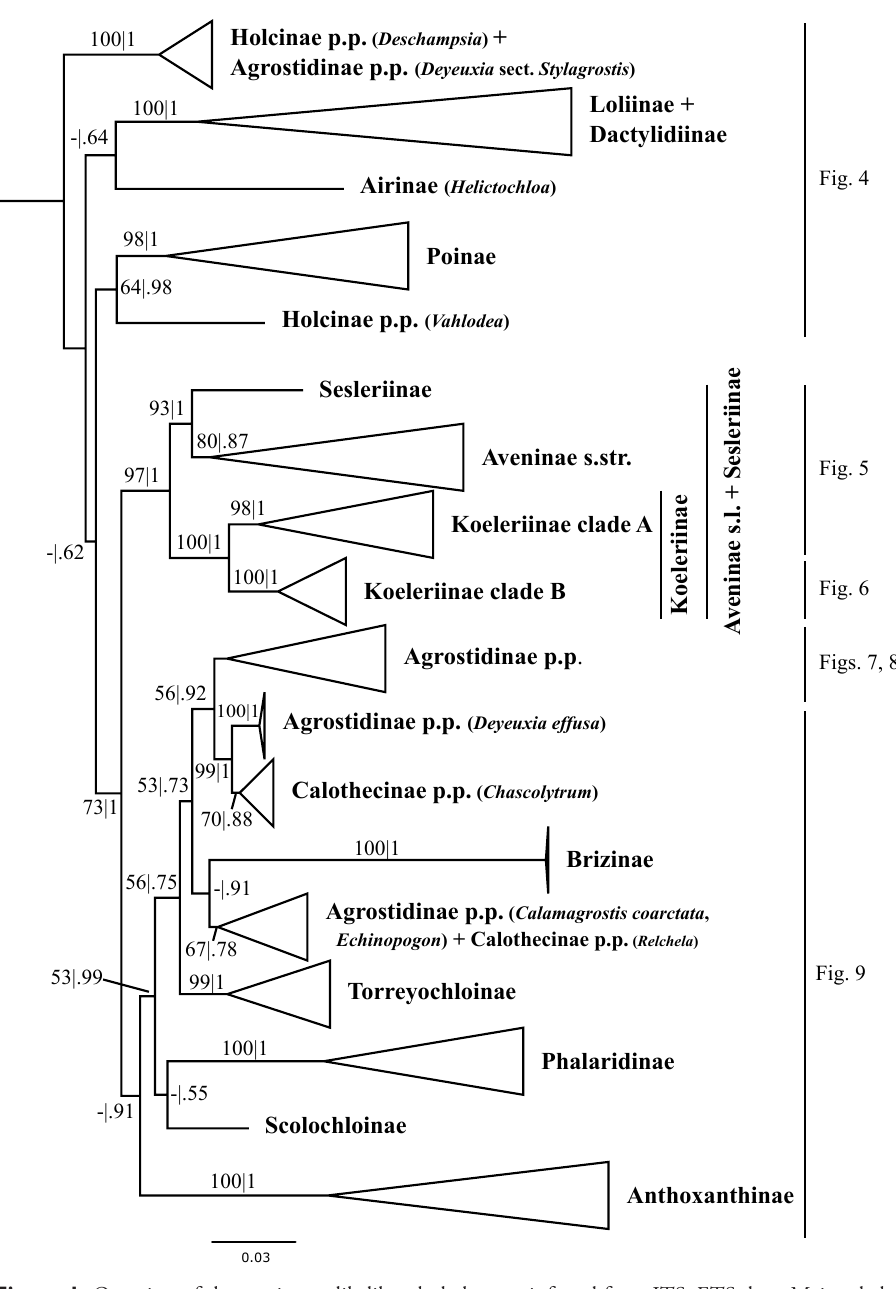
Figure 1. Overview of the maximum likelihood phylogram inferred from ITS+ETS data. Major clades in the complete tree are collapsed. The corresponding figures showing details of subsections of the tree are indicated. ML bootstrap support (left) and BI poster probabilities (right) are recorded along branches. A dash indicates bootstrap support <50%. No support is shown for branches with bootstrap support <50% and posterior probability <.5. The ML tree is presented in its entirety in Suppl. material